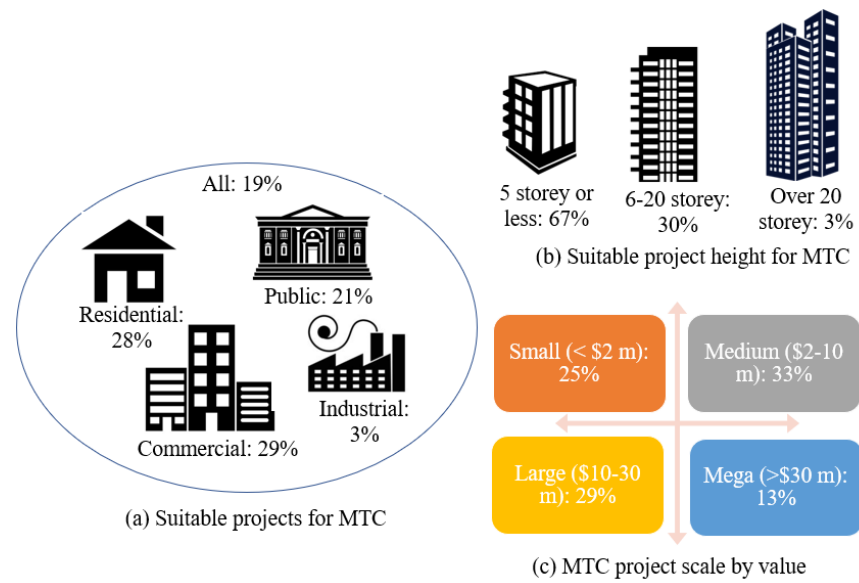
Figure 4. ( a – c ): The key MTC product and project characteristics.